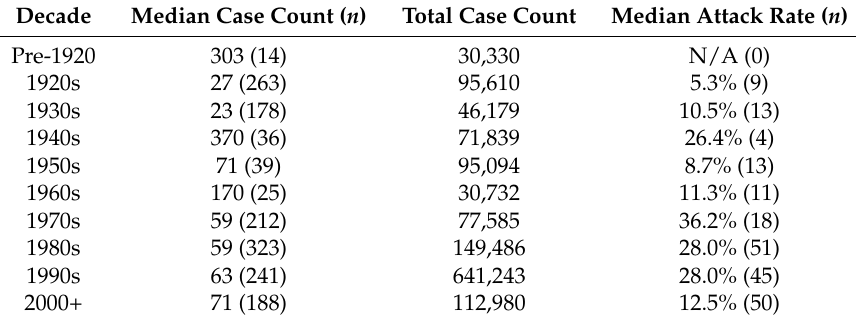
Table 2. Outbreak health data by decade.